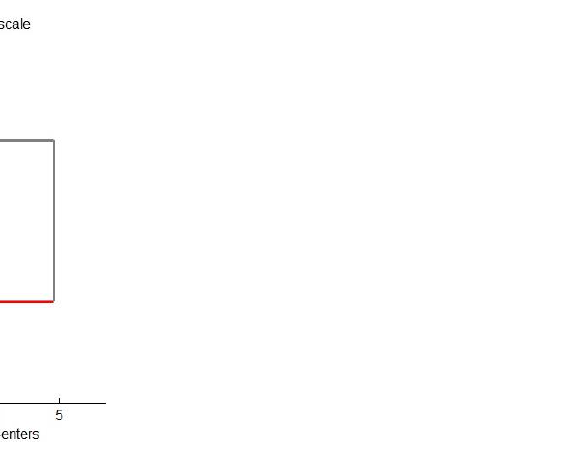
Figure 3. Dendrogram for cluster analysis (Ward’s method, using Mahalanobis distance) . Table 2. Correlation matrix for the studied variables.